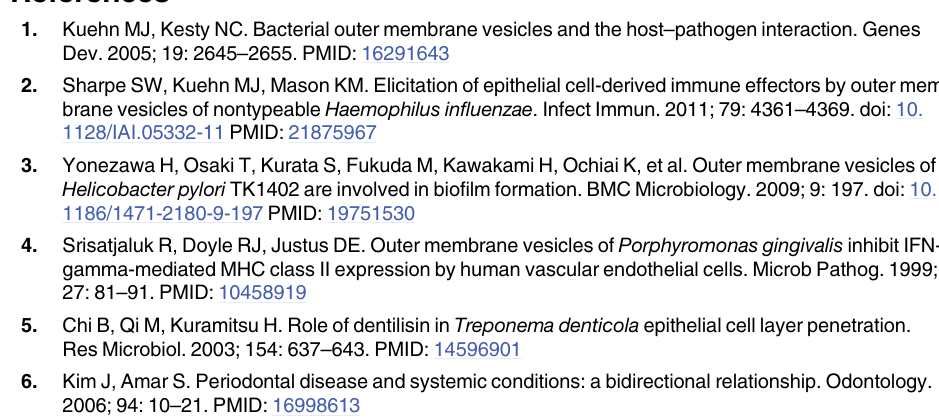
S2 Fig. Growth curve of T . denticola and T . forsythia . S3 Fig. Haemagglutination activity of P . gingivalis , T . denticola and T . forsythia OMVs. S1 Table. Protease activity of P . gingivalis , T . denticola and T . forsythia